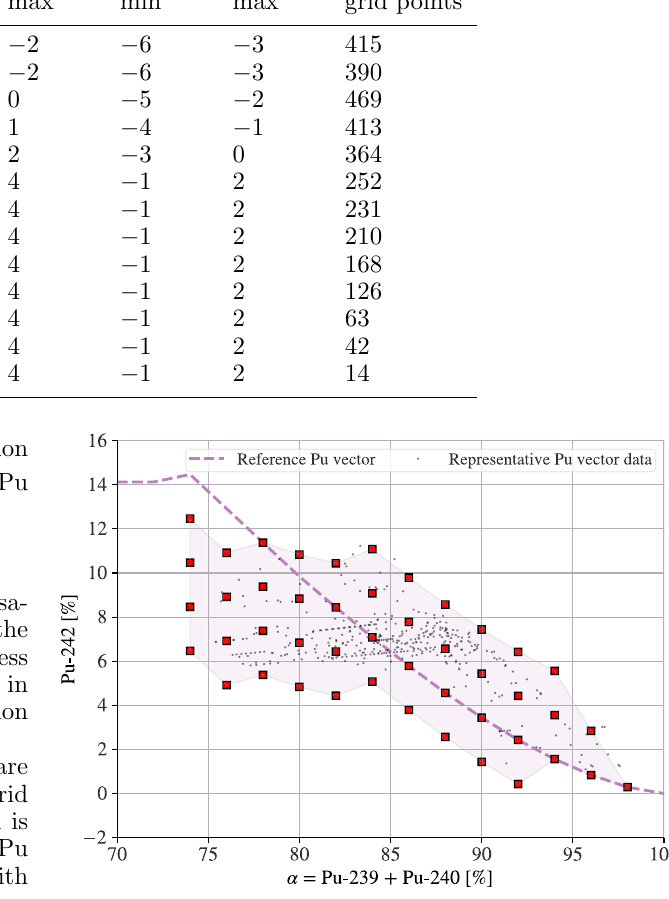
Fig. 2. Construction of the directive Pu vector grid (red squares) for 242 Pu that covers the physically accessible Pu vector